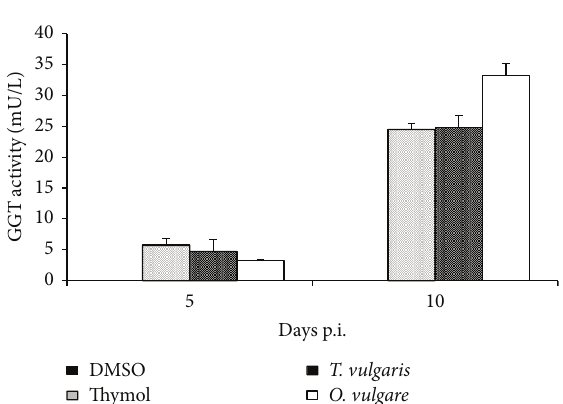
Figure 7: GGT activity detected in the supernatant of in vitro cultures of E. granulosus protoscoleces exposed to thymol and essential oils of T. vulgaris and O. vulgare .